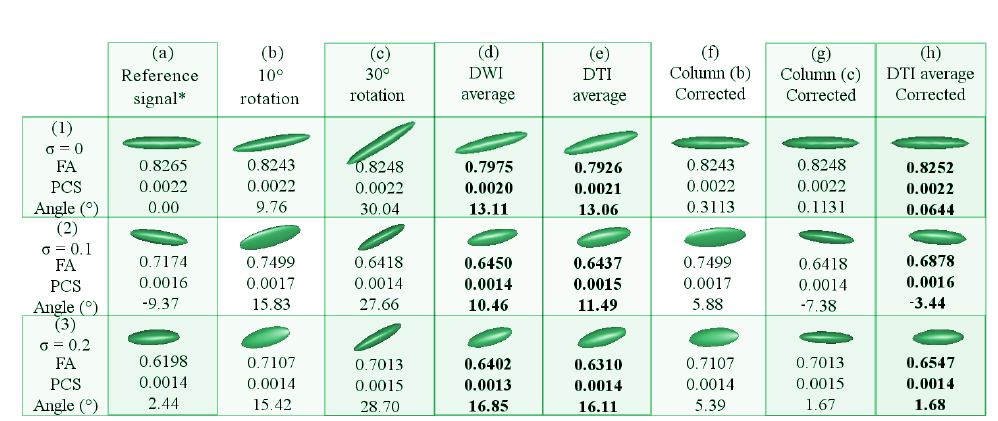
Figure 5: Results of the theoretical experiment using the new pipeline on synthetic data with rotated data.